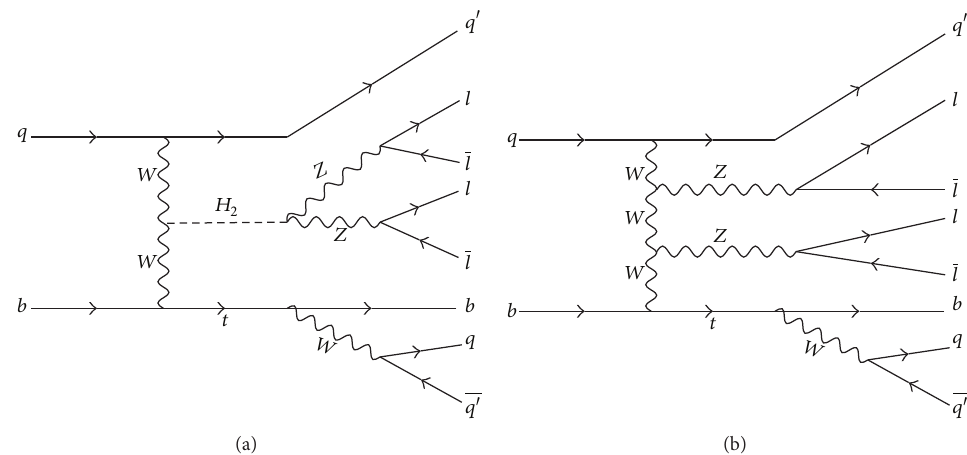
Figure 7: Feynman diagrams for signal 𝑝𝑝 → 𝑡𝐻 2 𝑗 (a) and background 𝑝𝑝 → 𝑡𝑍𝑍𝑗 (b) including the decay chain with hadronic top quark, leptonic 𝑍 boson decay, and Higgs decay 𝐻 2 → 𝑍𝑍 → ℓ + 1 ℓ − 1 ℓ + 2 ℓ − 2 at the